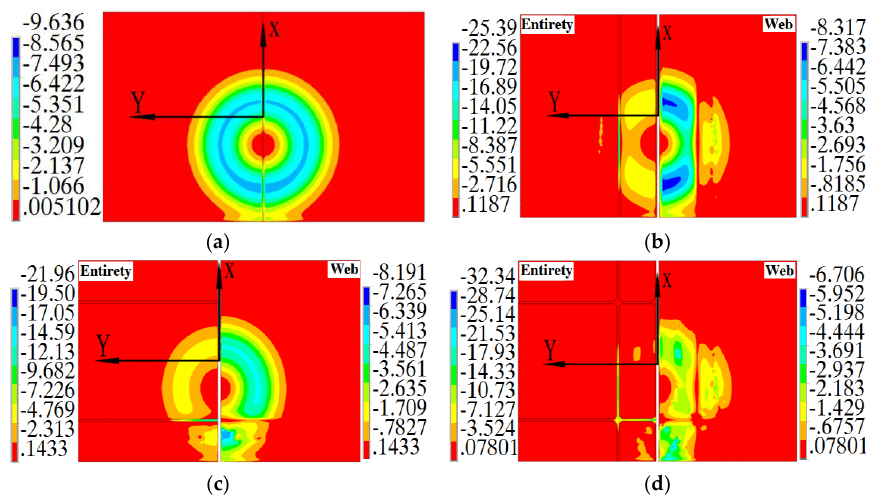
Figure 17. Electromagnetic force (N) distribution in four panels in the first discharge during EMIF: ( a ) Flat panel (FP); ( b ) X -rib panel (XP); ( c ) Y -rib panel (YP); and ( d ) Grid-rib panel (GP).